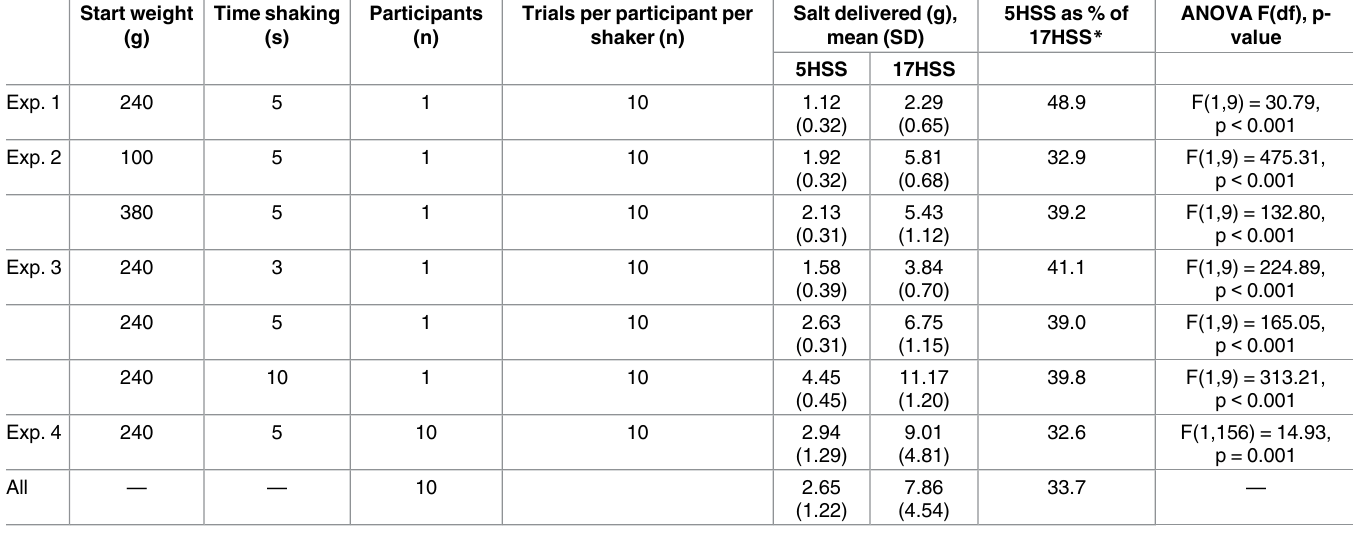
Table 1. difference in salt delivered by five versus 17 holed salt shakers. Start weight